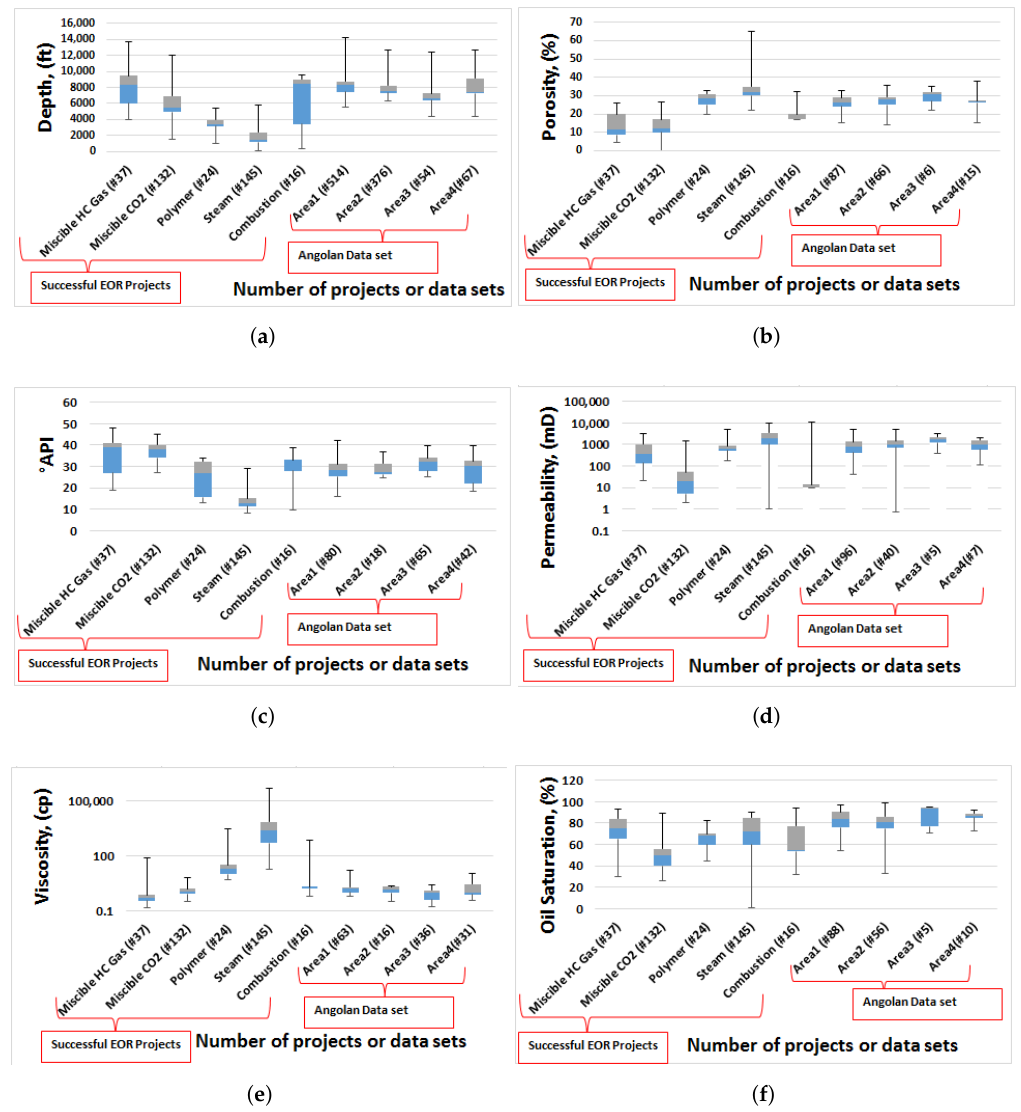
Figure 10. Reservoir properties distribution vs. EOR methods. ( a ) Depth; ( b ) porosity; ( c ) API; ( d ) permeability; ( e ) viscosity; and ( f ) saturation. Data source of Worldwide successful EOR: [15,38]; Angolan oilfield data: Sonangol